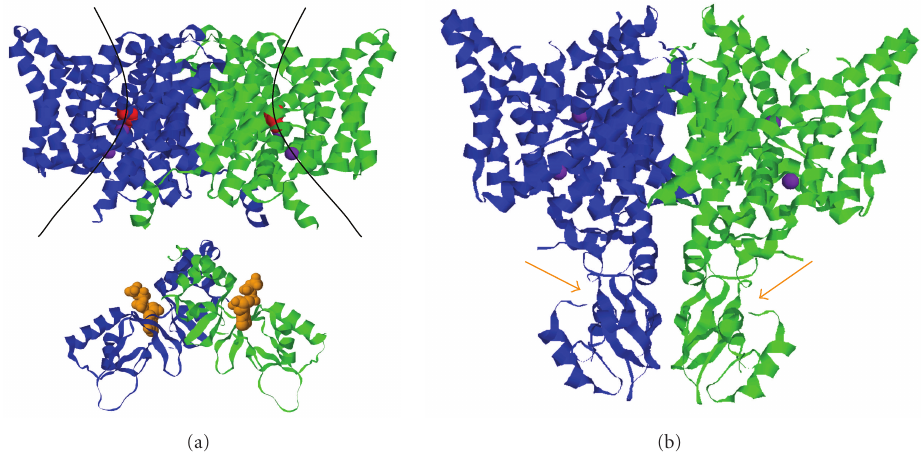
Figure 2: Molecular architecture of mammalian CLC molecules. (a) The composite structure of a generic CLC molecule consists of two parts: the membrane region, represented by the crystal structure of E. coli CLC molecule (CLC-ec1) (top), and the cytoplasmic domain represented by the crystal structure of the cytoplasmic domain of CLC-5. The two subunits are colored in green and blue, respectively. The two curve lines in the membrane portion roughly depict the transport pathways of Cl − ions (purple spheres). Red residues are Glu 148 of CLC-ec1, which correspond to Glu 232 of CLC-1. The negatively charged side chain of this residue obstructs the ion-transport pathway, and therefore is hypothesized to be the fast gate of CLC-channels. The two space-filled molecules in orange color in the cytoplasmic domains (one in each subunit) are ATP molecules seen in the crystal structure of the CLC-5’s cytoplasmic domain. Binding of ATP to CLC-1 inhibits the common gating of CLC-1. (b) X-ray crystal structure of CmCLC, a CLC protein from a thermophilic red alga Cyanidioschyzon merolae . Orange arrows point to the ATP-binding